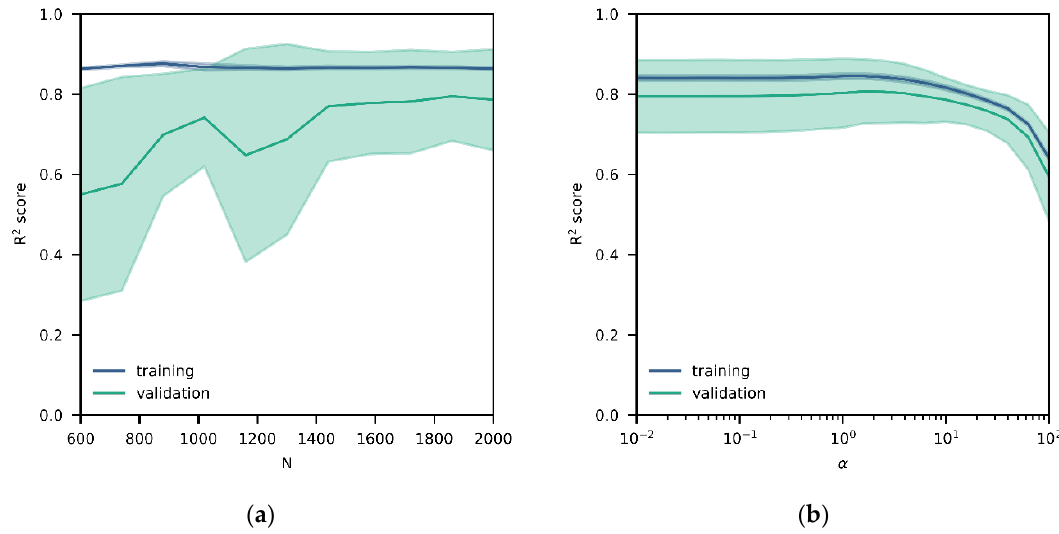
Figure 1. ( a ) Learning curve for training (blue) and validation (green) data sets for the final neural network (NN) model (with mean and standard deviation); validation set performance increases with increasing sample size N and flattens above 1600 instances; ( b ) validation curve for training (blue) and validation (green) data sets for the final NN model (with mean and standard deviation); validation set performance decreases with increasing α, i.e., a too simplified model, but is fairly stable below values of α = 1.